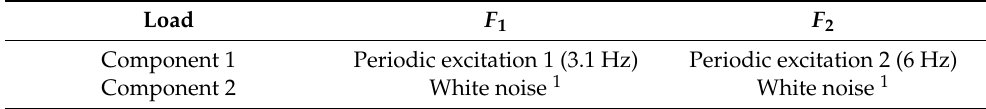
Figure 5. Transmissibility t 34 of response in a finite time period (20 groups).